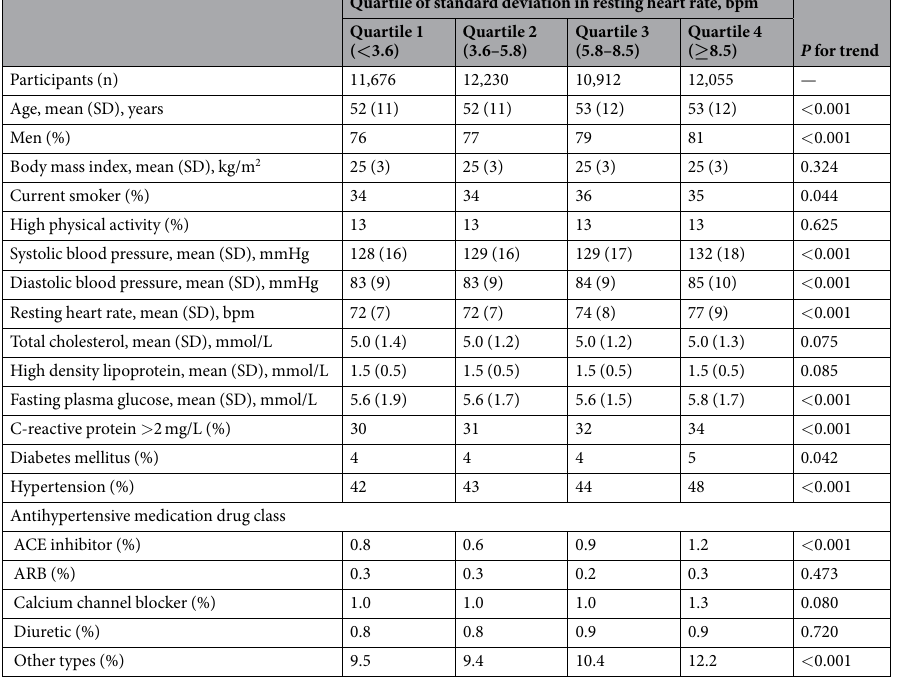
RHR variation was associated with cardiovascular and total mortality by using a day-by-day measurement. For example, Kikuya et al . demonstrated that higher day-by-day heart rate variation was associated with cardiovascu-